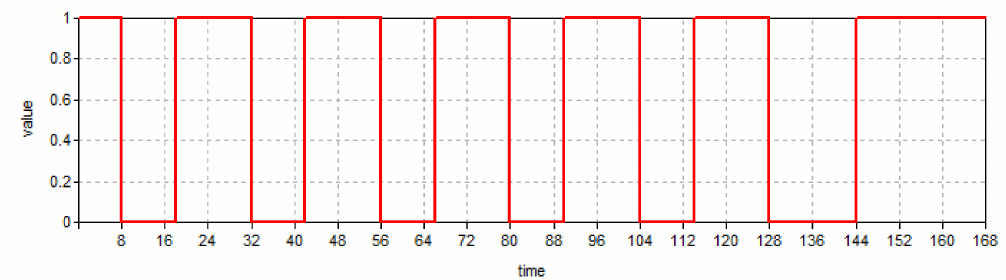
Figure 18. Week occupation scenario.